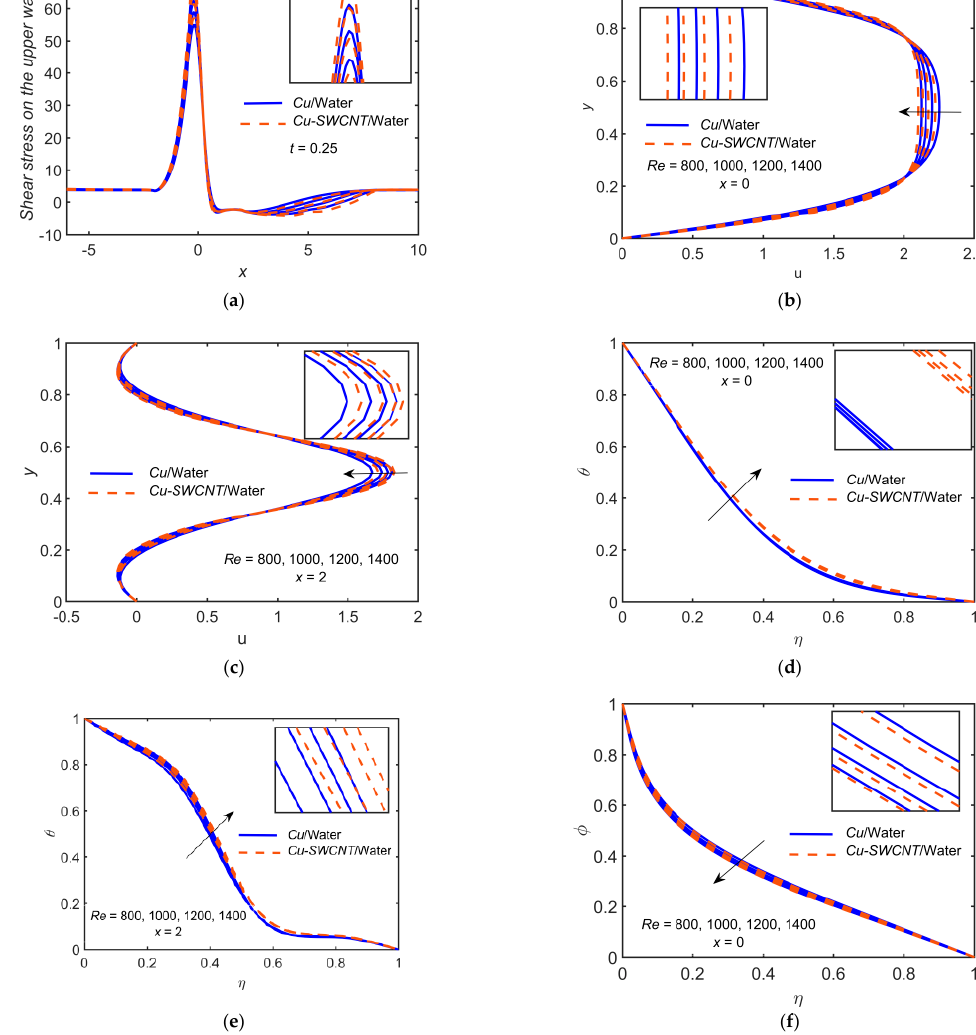
Figure 7. ( a ) The WSS distribution, ( b ) 𝑢 profile at 𝑥 = 0 , ( c ) 𝑢 profile at 𝑥 = 2 , ( d ) 𝜃 profile at 𝑥 = 0 , ( e ) 𝜃 profile at 𝑥 = 2 , and ( f ) 𝜑 profile at 𝑥 = 0 for distinct values of 𝑅𝑒 .